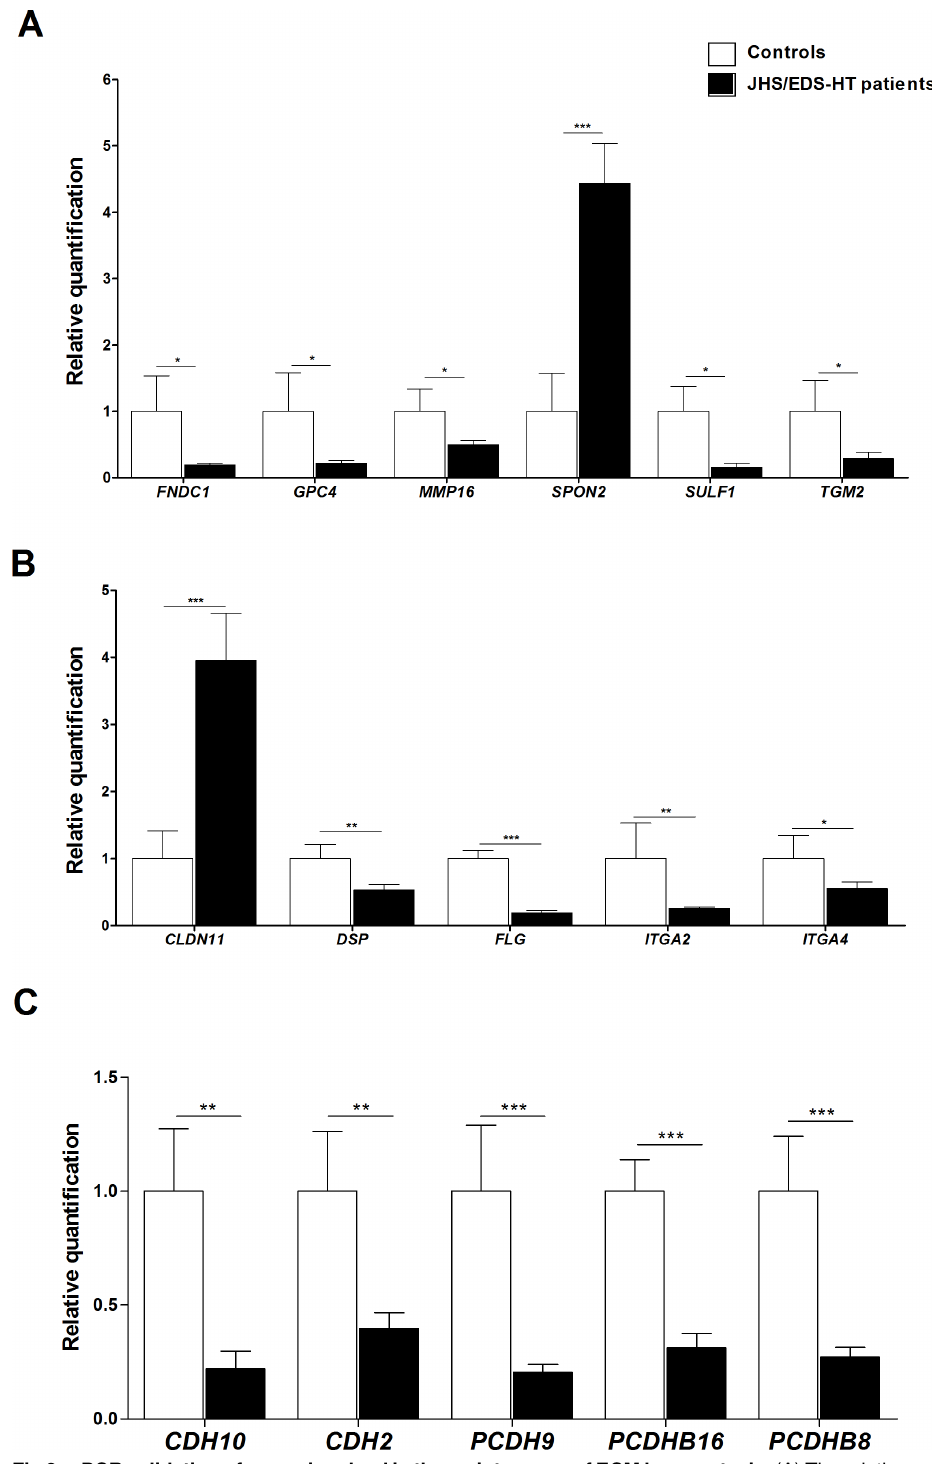
Fig 2. qPCR validation of genes involved in the maintenance of ECM homeostasis. (A) The relative mRNA expression levels of selected genes related to ECM organization, (B) ECM-cell interaction, and (C) genes belonging to cadherins superfamily, were determined with the 2 -( ΔΔ Ct) method normalized with the geometric mean of the HPRT , GAPDH , ATP5B , CYC1 , and RPLP0 reference genes. Bars represent the mean ratio of target gene expression in five patients ’ fibroblasts compared to five unrelated healthy